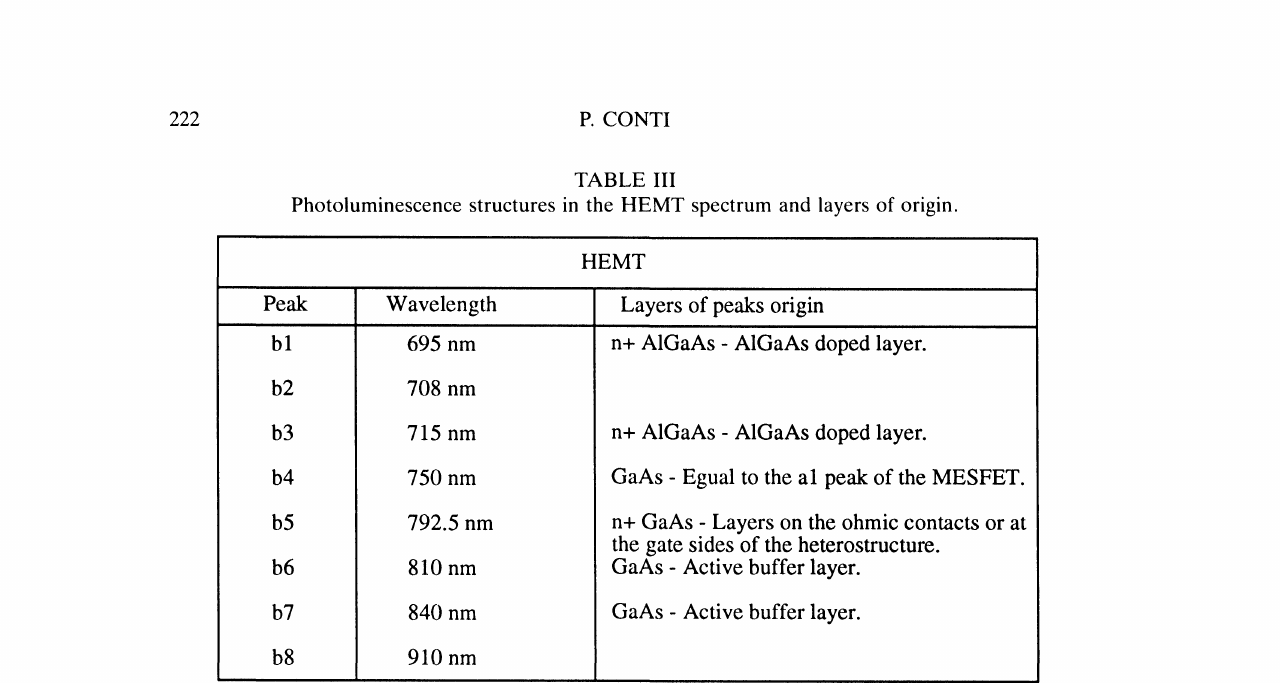
Photoluminescence structures in the HEMT spectrum and layers of origin.